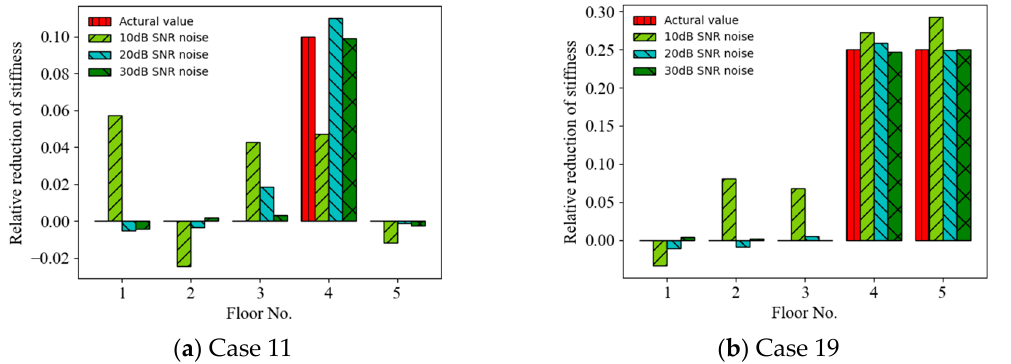
Figure 5. Mean prediction results of structural anomaly using acceleration responses as ANN input for different noise intensities.